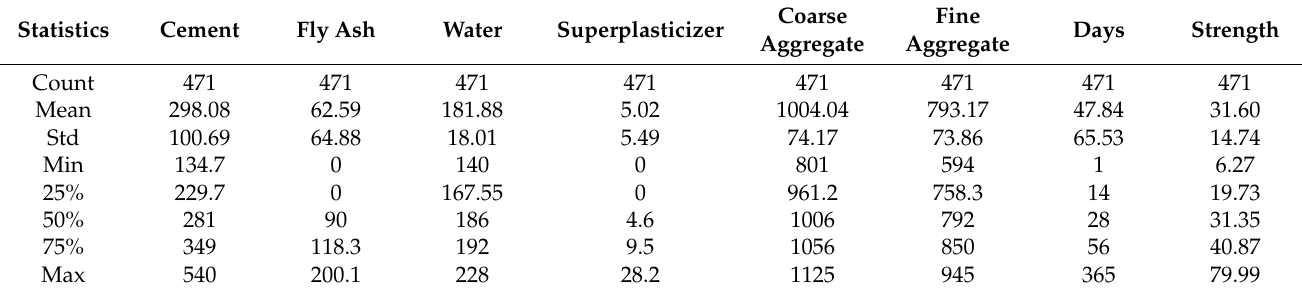
Table 4. Statistical indication of parameters.